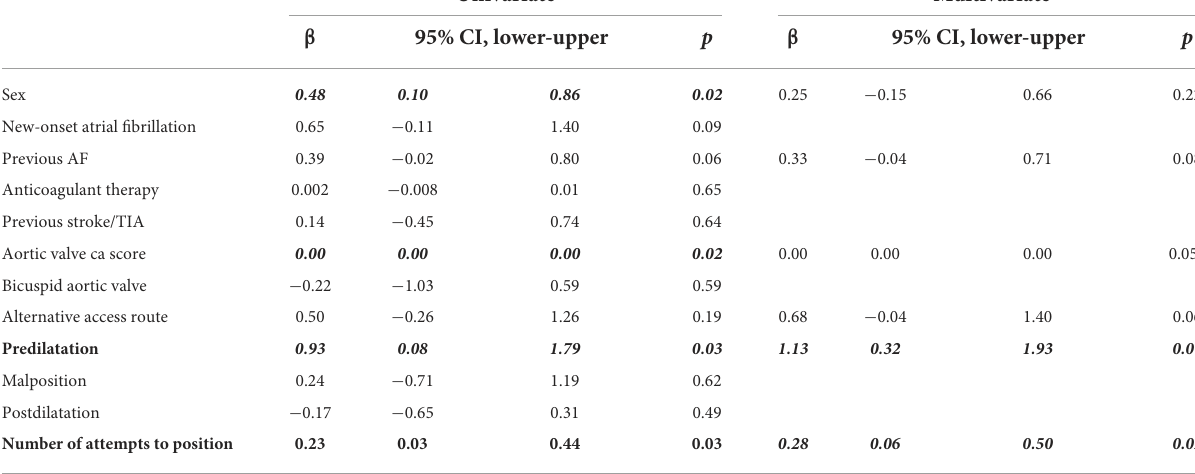
TABLE 4 Multivariate linear regression analysis of the predictors of total ischemic volume. Univariate Multivariate